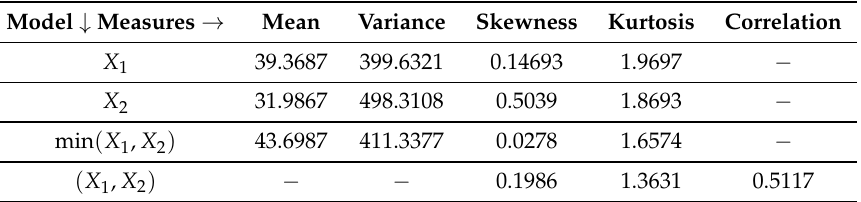
Table 8. Some descriptive statistics for data set I.